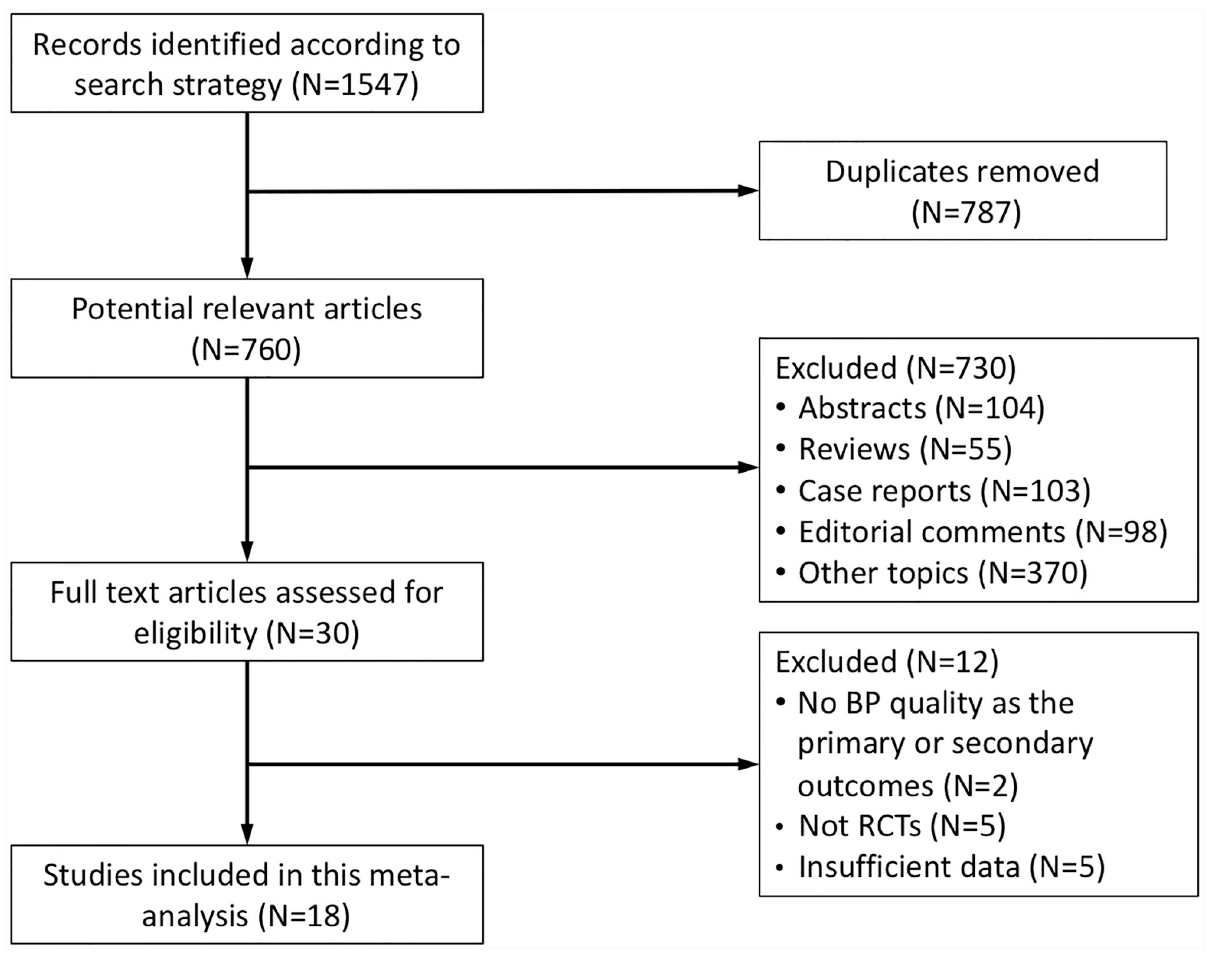
Fig 1. Flow chart for search